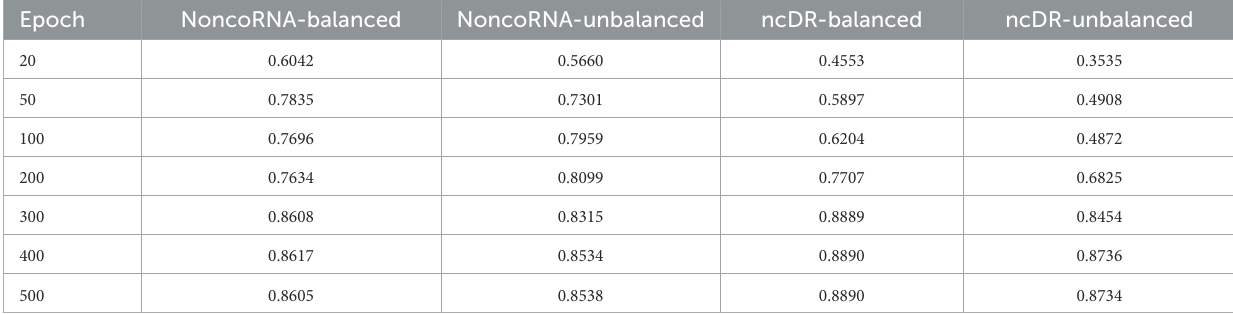
TABLE 2 Changes in average model performance on balanced and unbalanced datasets. Epoch NoncoRNA-balanced NoncoRNA-unbalanced ncDR-balanced